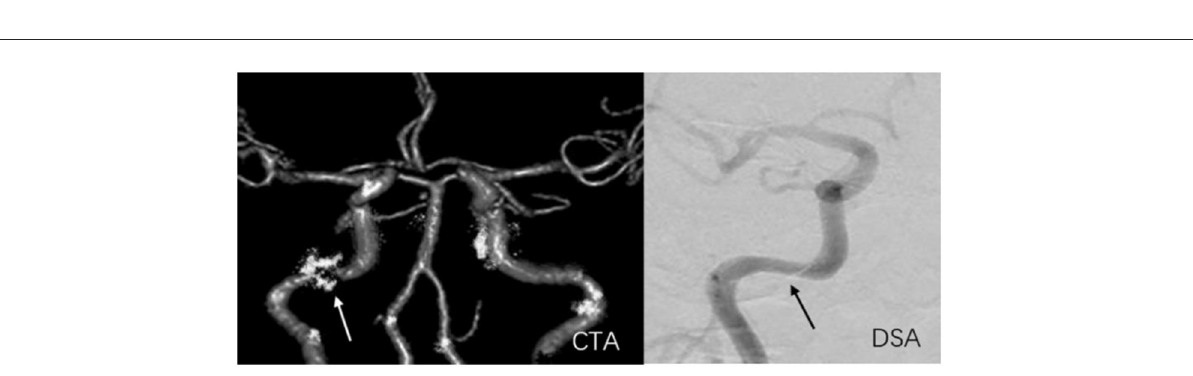
FIGURE7 A 59-year-old man with stenosis and calcification on C2 of the right internal carotid artery. The arrow marks the location of the lesion. The degree of stenosis acquired on CTA (81.7%) exceeded that on DSA